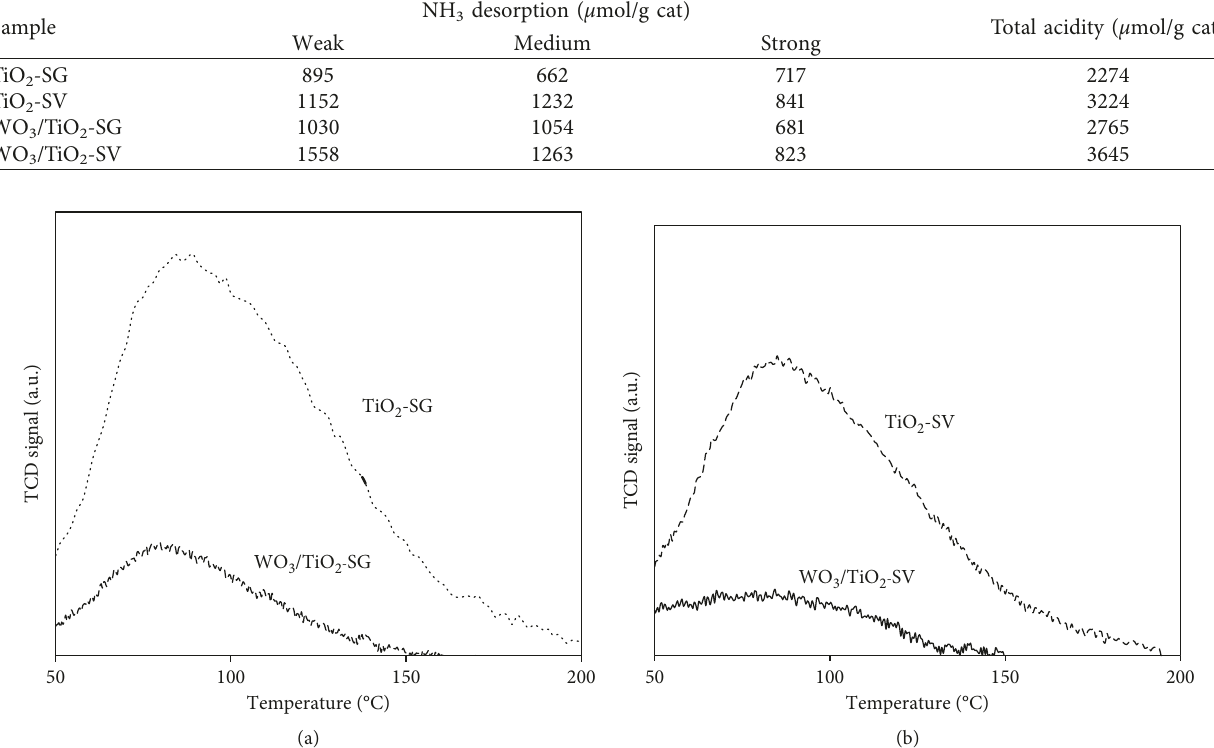
Table 3: The amount of surface acidity of supports and catalysts measured by NH Sample